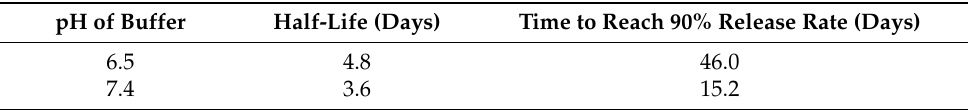
Table 2. The theoretical half-life of antibody nanoparticles loaded with MC and CAPE and theoretical time required to reach a 90% release